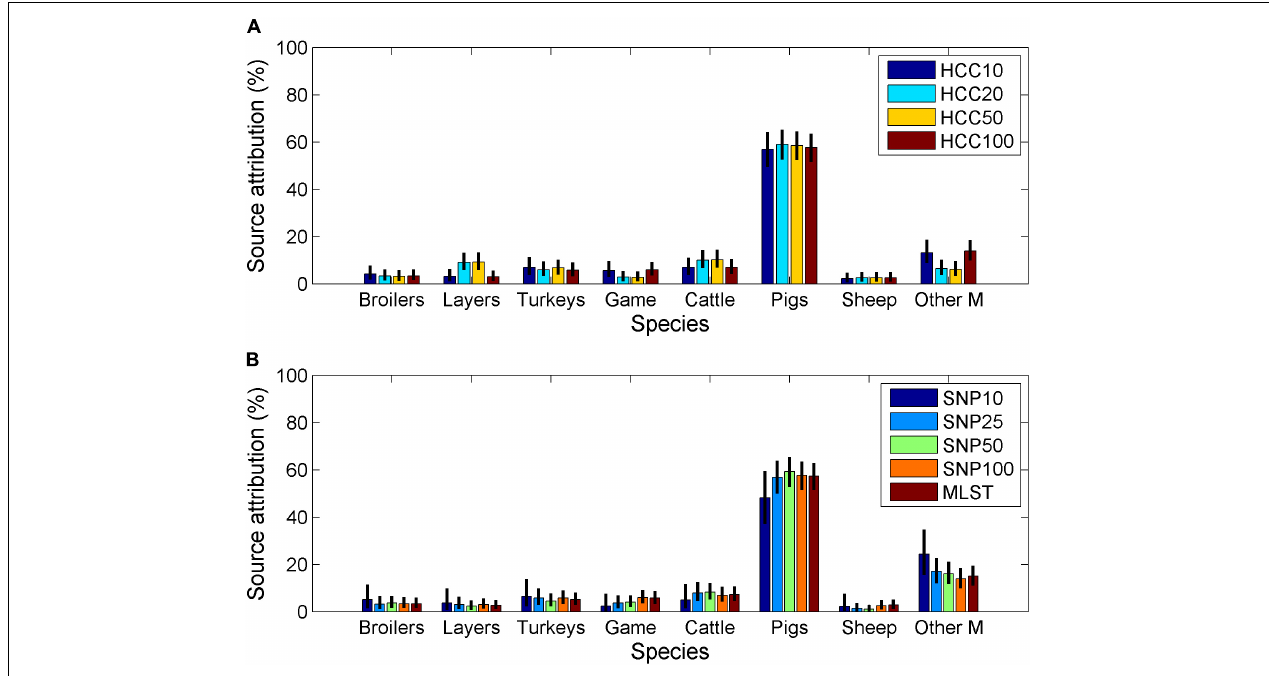
FIGURE 2 | Estimated source attribution for Salmonella Typhimurium (including monophasic variants) for (A) isolates typed using core-genome MLST data and (B) isolates typed by SNP distance or 7-loci MLST (Other M = other mammals, Game = game